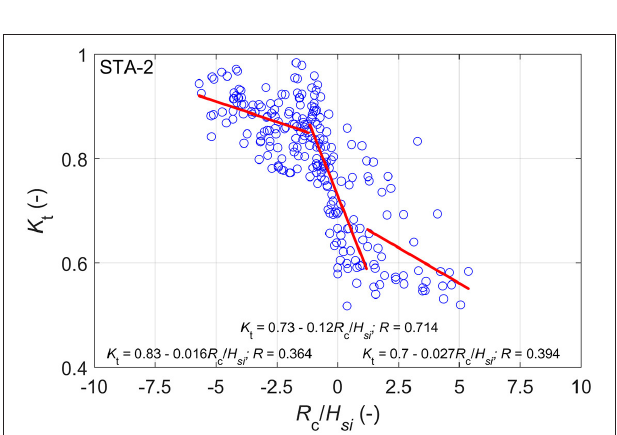
FIGURE 8 | The relationship of the wave transmission coefficient K t and the relative fence freeboard R c /H st .